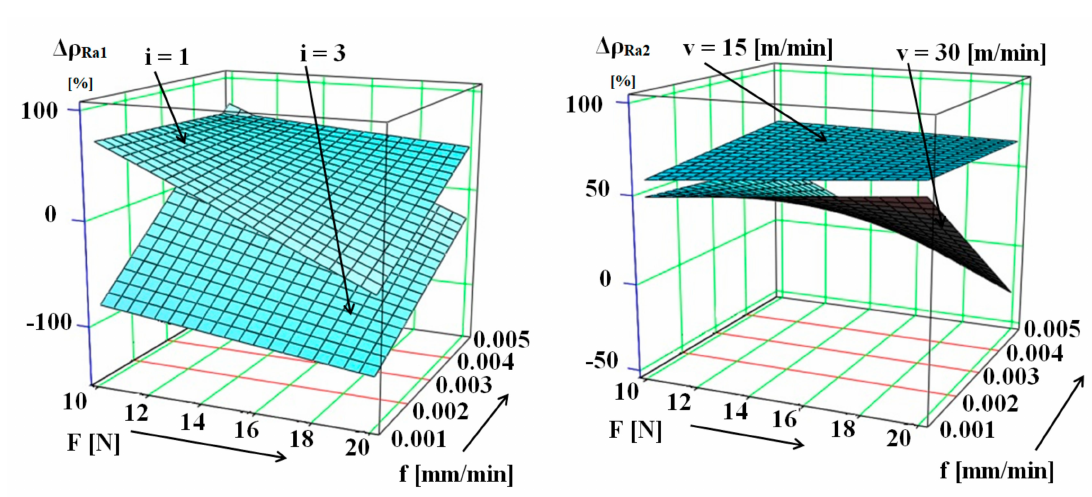
Figure 3. Changes in R a for Experiment I ( left ) and Experiment II ( right